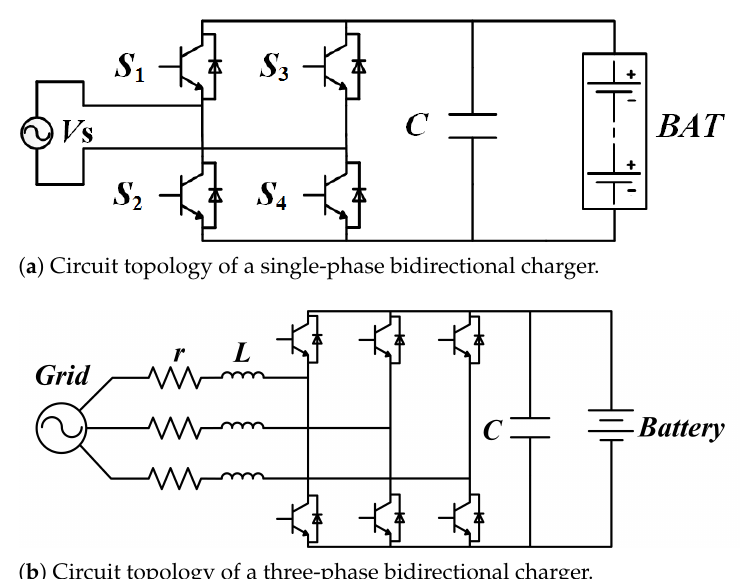
Figure 2. Bidirectional charger